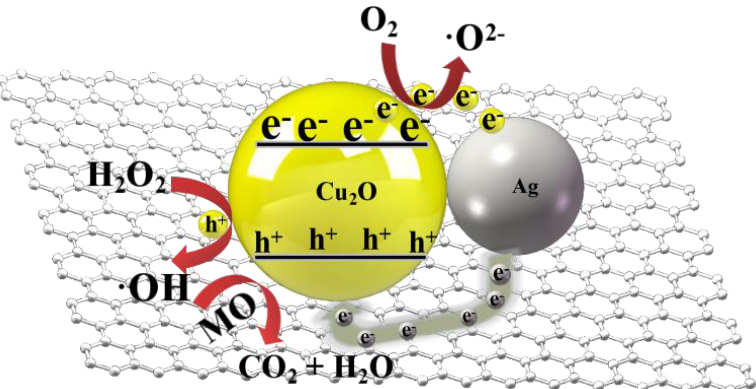
Figure 8. Schematic illustration of the Ag@Cu 2 O-rGO charge transfer in the photocatalytic degradation process of MO.